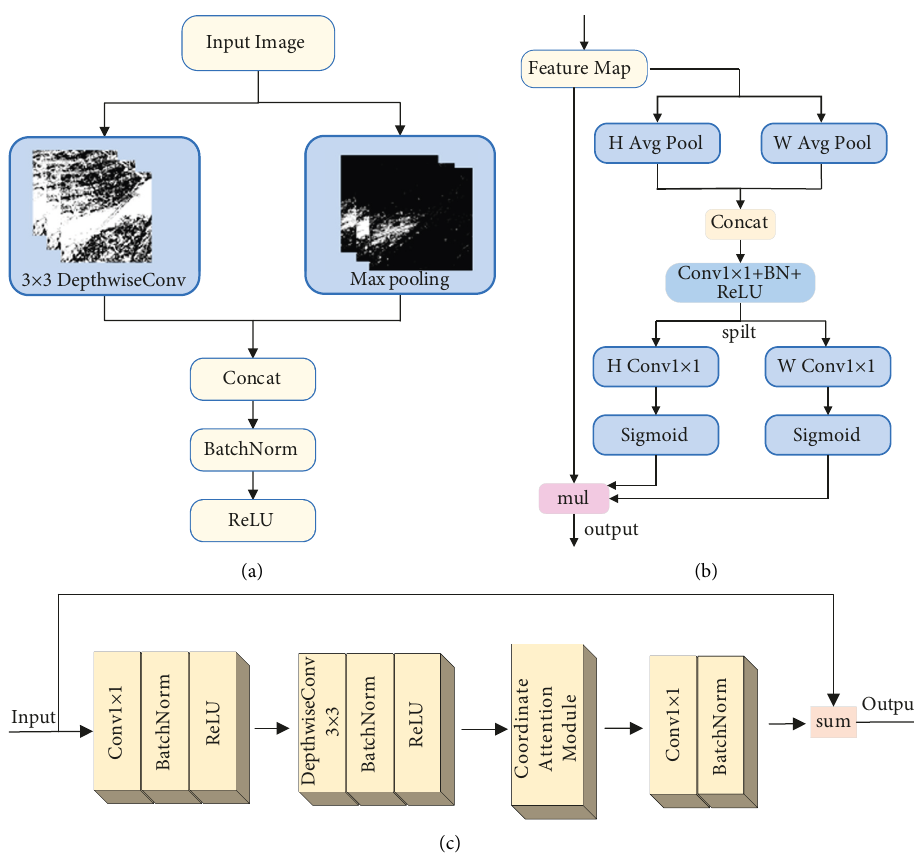
Figure 3: Encoder path components. (a) Components of the Initial Module. (b) Coordinate Attention Module. (c) Overall composition of CA-Bottleneck